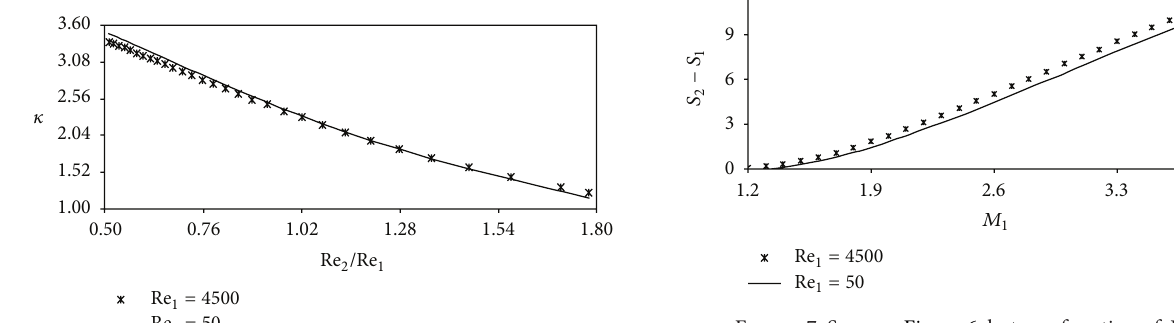
Figure 7: Same as Figure 6, but as a function of 𝑀 1